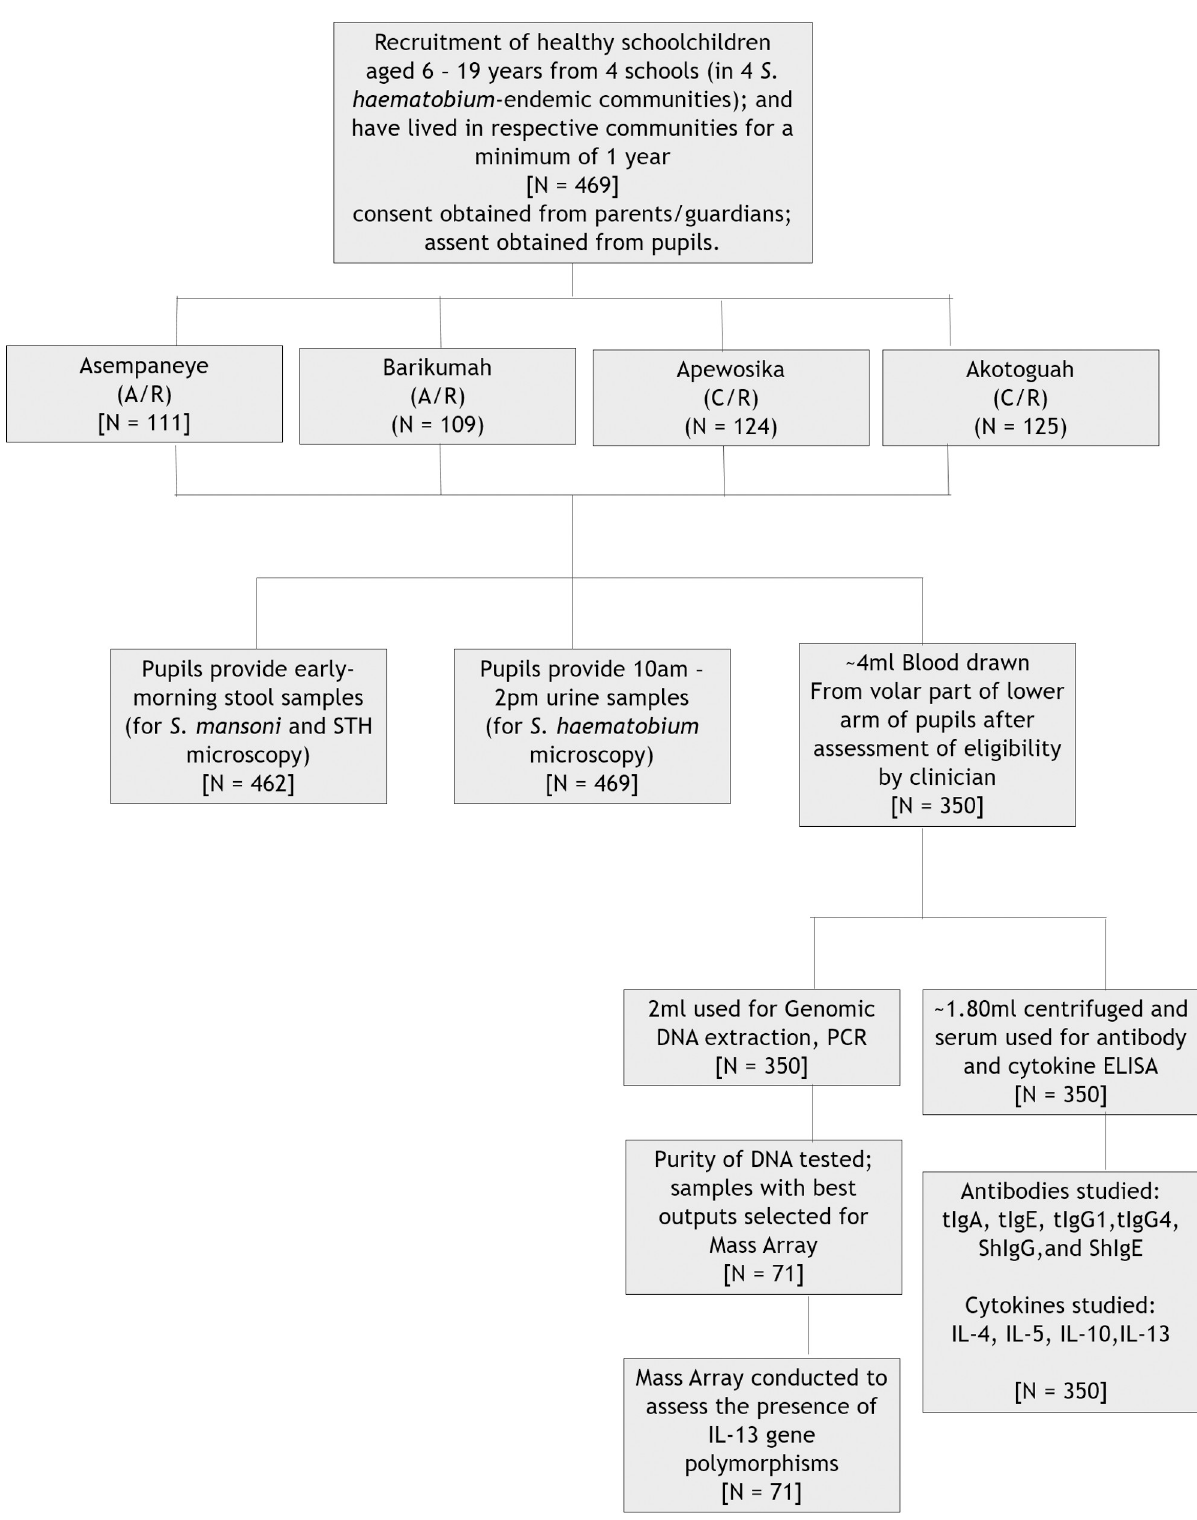
Fig 1. Flow chart of the study detailing the number of pupils involved at each phase (i.e. for each of the techniques employed). A/R denotes the Ashanti Region of Ghana; C/R represents the Central Region.